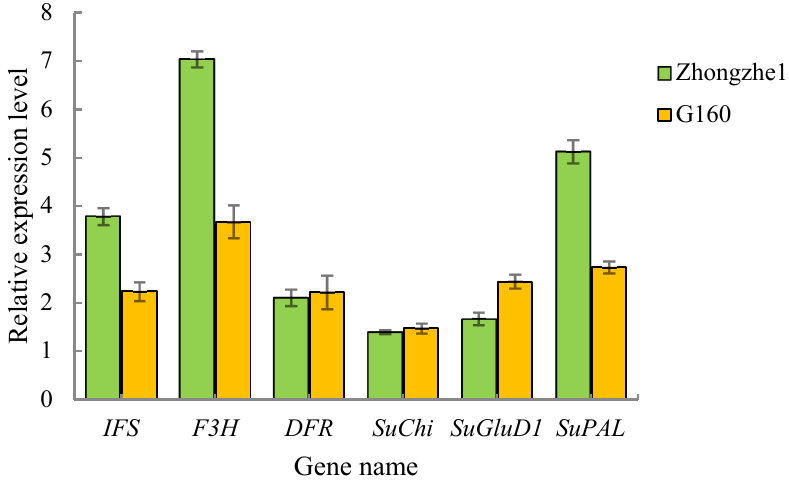
Figure 5. Results of a qRT–PCR analysis of 6 genes that encode key synthesis-related enzymes in the leaves of sugarcane varieties (Zhongzhe 1 sugarcane and G160).